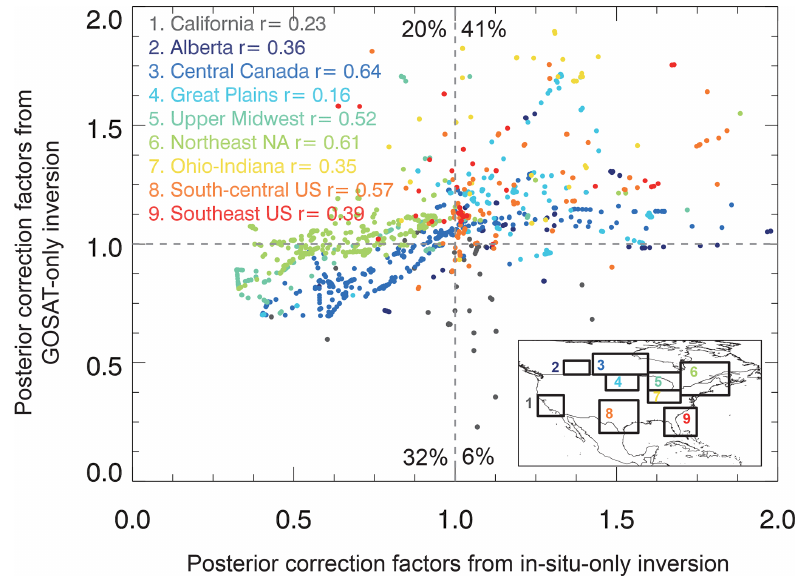
Figure 4. Comparison of posterior correction factors to prior methane emissions on the 0 . 5 ◦ × 0 . 625 ◦ grid between GOSAT-only and in- situ-only inversions. The comparisons are for nine regions with relatively high averaging kernel sensitivities for both inversions. Each point represents the posterior correction factors from both inversions in a 0 . 5 ◦ × 0 . 625 ◦ grid cell (Fig. 3). Correlation coefficients for each of the nine regions are shown in the inset. Percentiles in each quadrant show the fraction of the total points in that